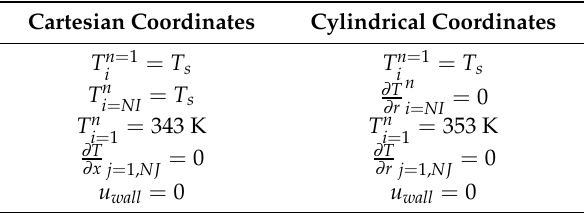
Table 3. Initial and boundary conditions.